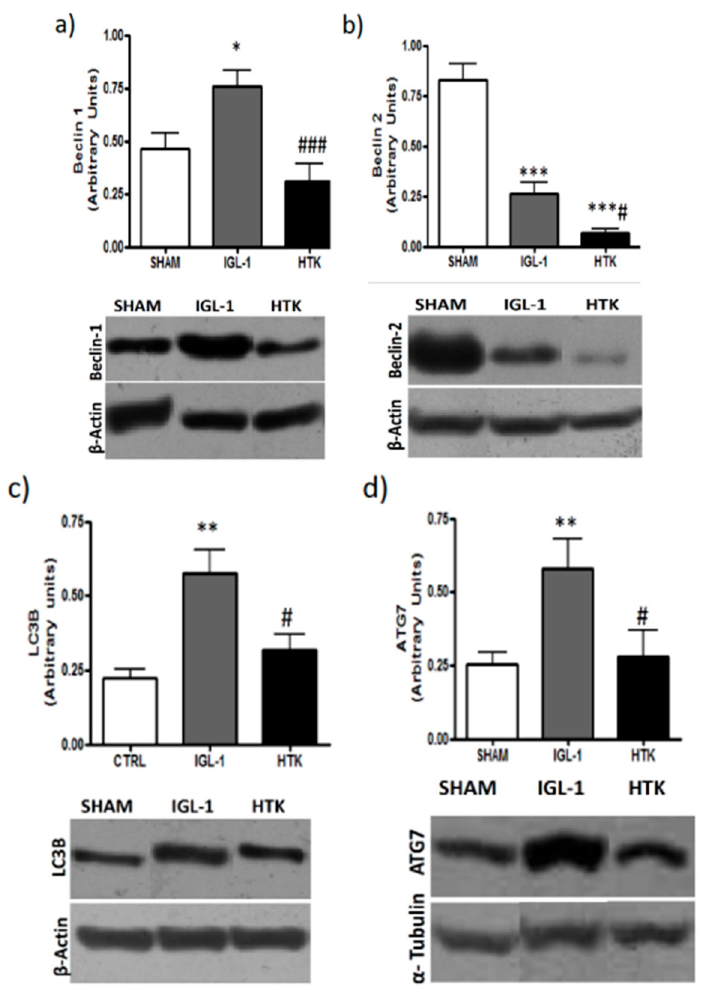
Figure 4. Liver autophagy in fatty liver grafts stored in IGL-1 and HTK vs. controls (24 h; 4 °C) measured as Beclin 1 ( a ), Beclin 2 ( b ), LC3B ( c ) and ATG7 ( d ). Bar graphs represent the mean ± SD. * p < 0.05 vs. SHAM, ** p < 0.005 vs. SHAM, *** p < 0.0005 vs. SHAM, # p < 0.05 vs. IGL-1, ### p < 0.0005 vs. IGL-1.